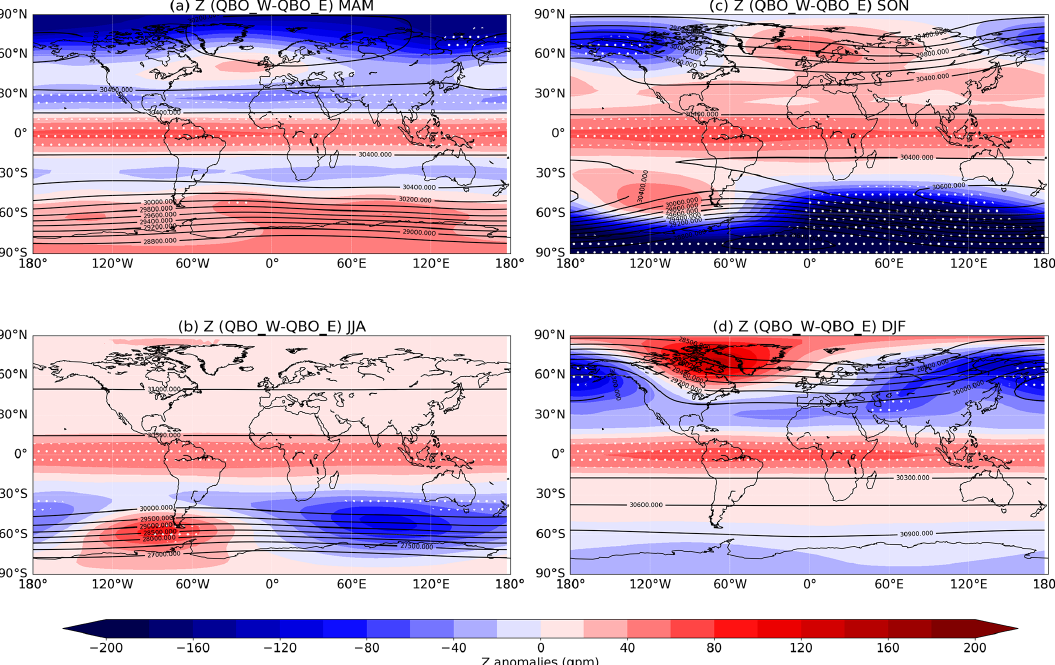
Figure 11. Influences of QBO (QBOW–QBOE) on global geopotential height ( Z at 10hPa), based on ERA5 data for the period 1979–2020. The climatological values of geopotential height during QBOE in each season are also shown (contour lines, with contour intervals of 200, 500, 200, and 300gpm in panels (a) , (b) , (c) , and (d) , respectively). (a) MAM. (b) JJA. (c) SON. (d) DJF. Stippled areas indicate results that are statistically significant over the 95% level, using the two-tailed Student’s t